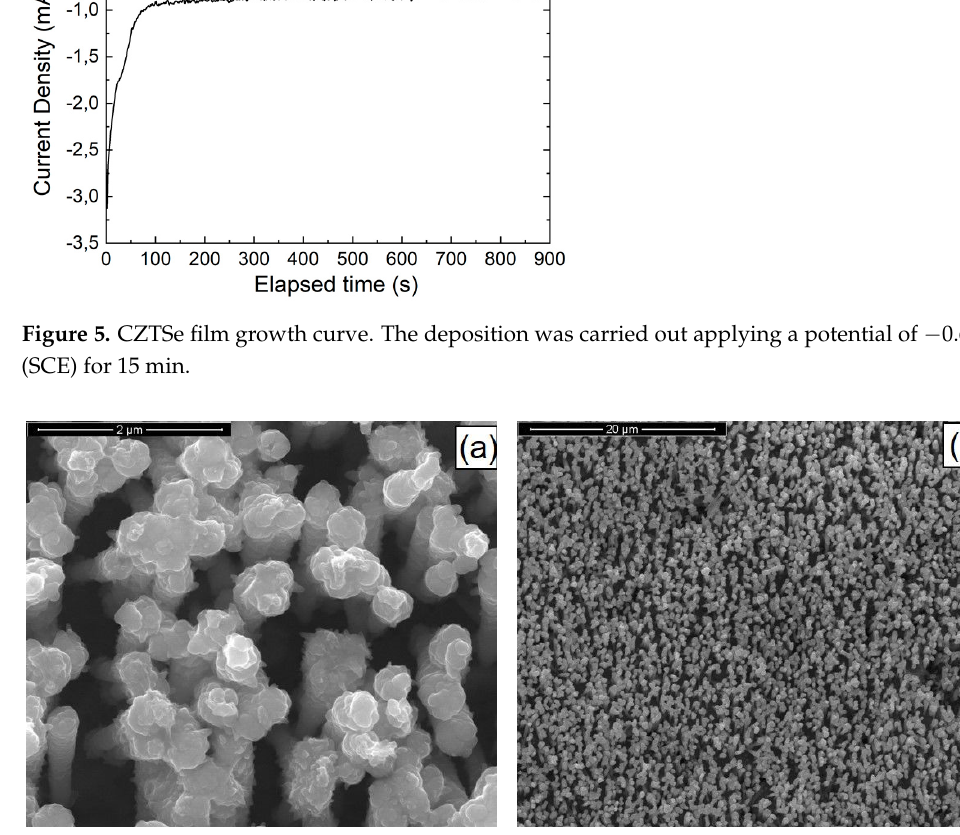
Figure 7. Raman spectra of the CZTSe NWs obtained using an electrodeposition bath at different pHs and Cu content (see Table 1). Table 2. Summary of Raman analysis of CZTSe nanowires. Compound